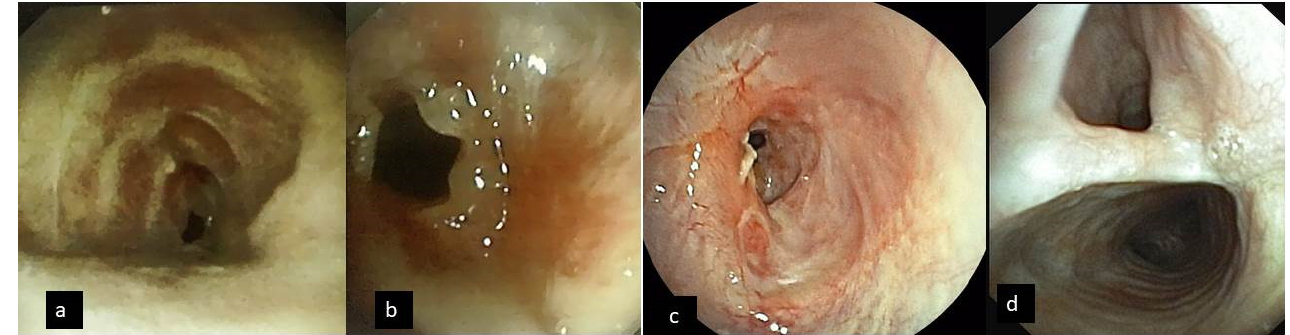
Figure 2. Bronchoscopic view of severe complex upper trachea stenosis ( a – c ) and tracheoesopha- geal fistula ( d ).